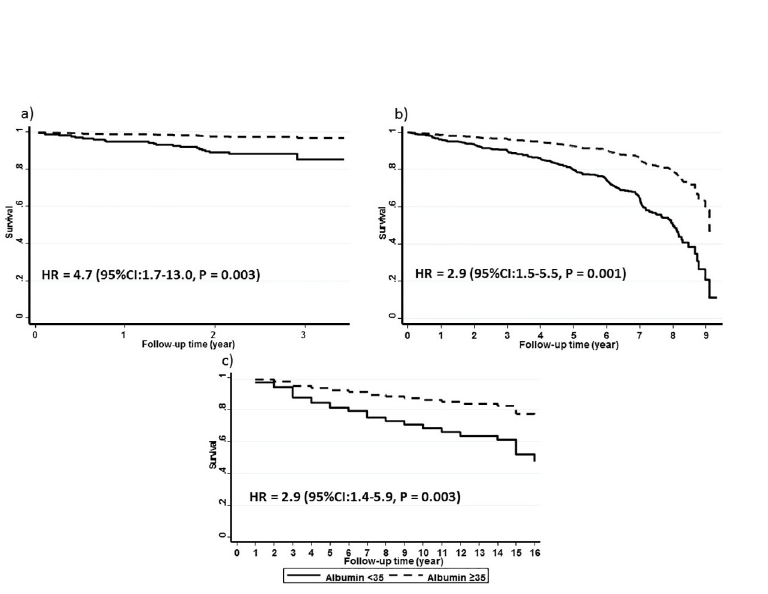
Fig 1. Low serum albumin ( < 35 g/L solid line) predicts higher mortality among sickle cell disease patients in a) Walk- PHaSST b) CSSCD and c) OMG-SCD cohorts. Graphs show the age and hemoglobin adjusted survival in each cohort.